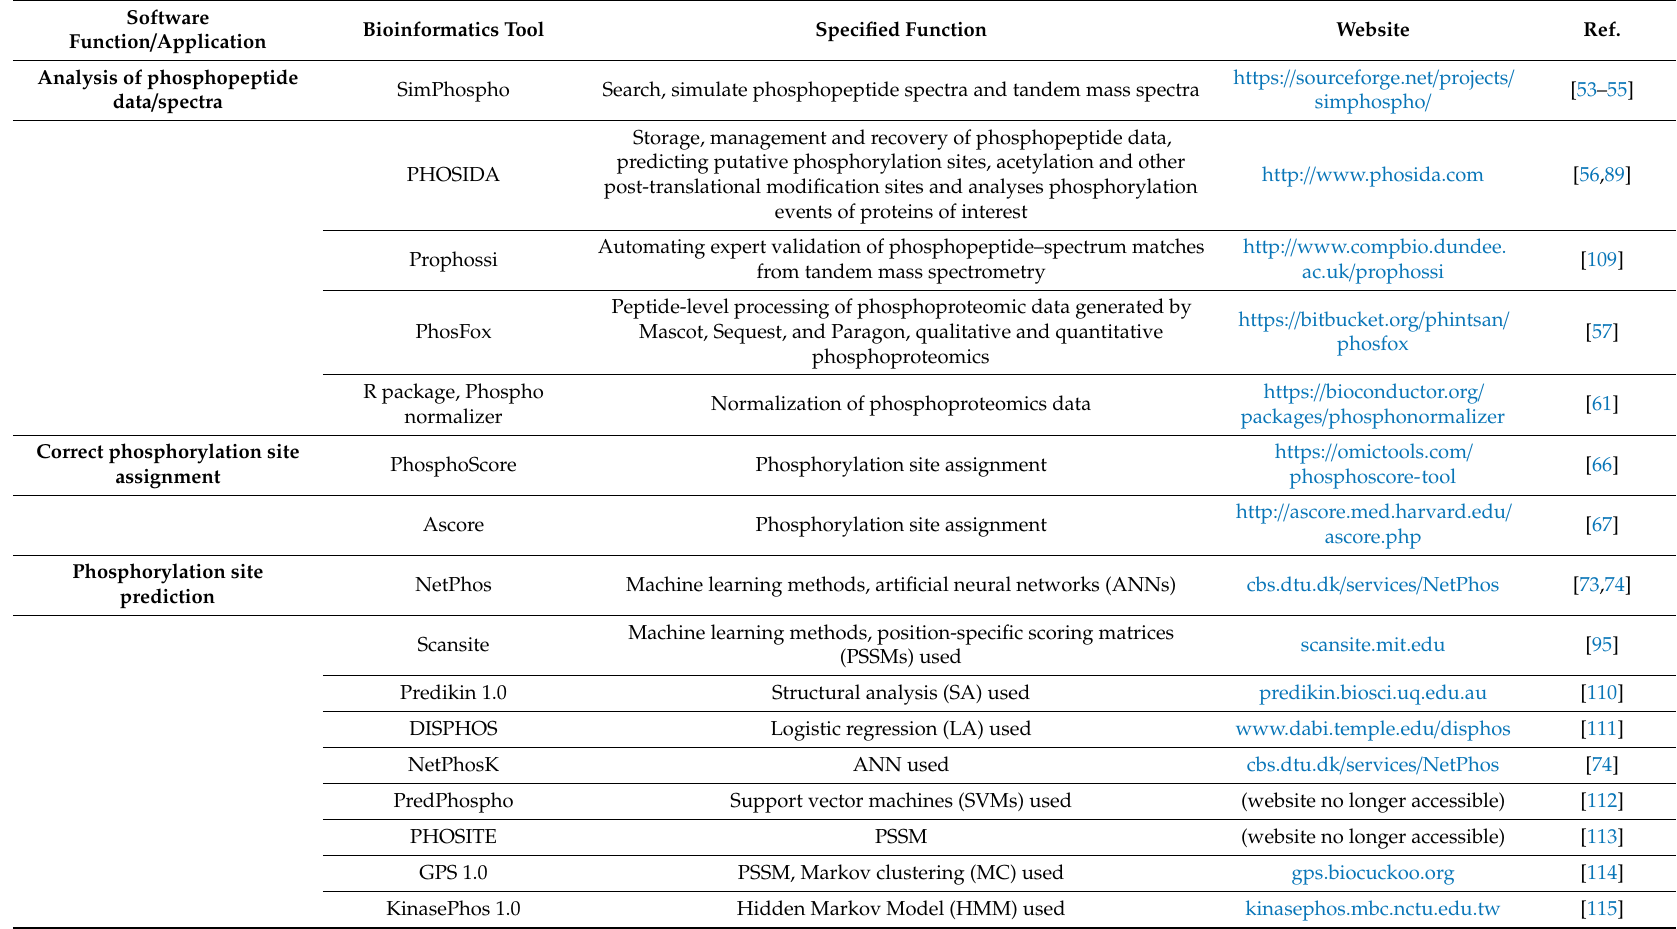
Table 1. Overview of software options available for